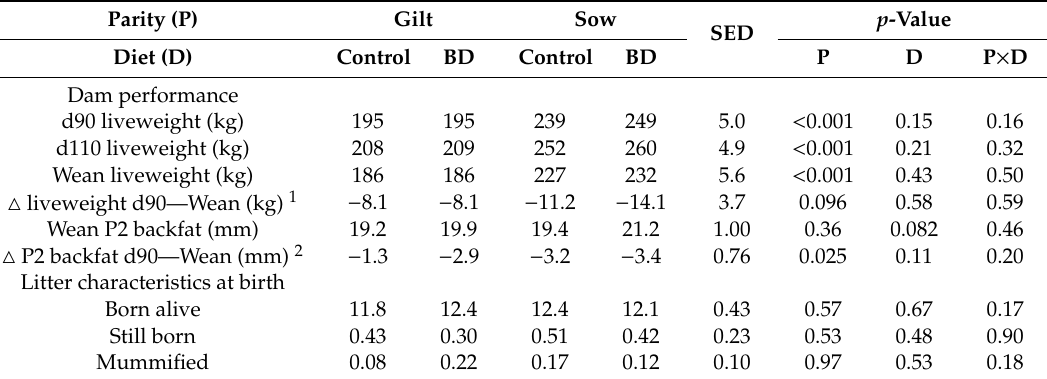
Table 2. Farrowing performance of gilts and sows fed a control or a 1,3-Butanediol (BD) diet, and their litter